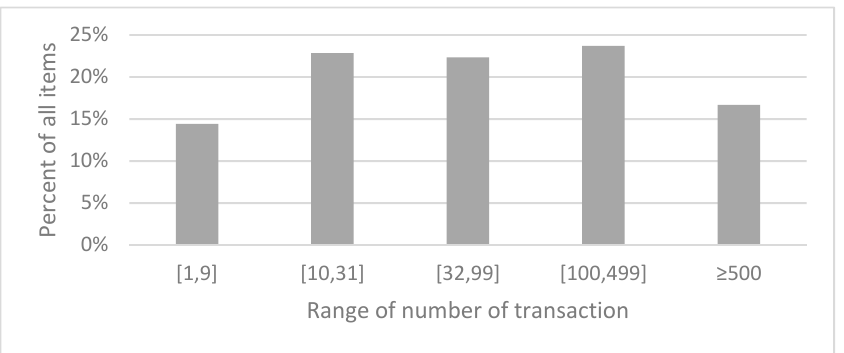
Figure 3. The percentage share of the number of items from a given interval of transactions number in all item numbers.